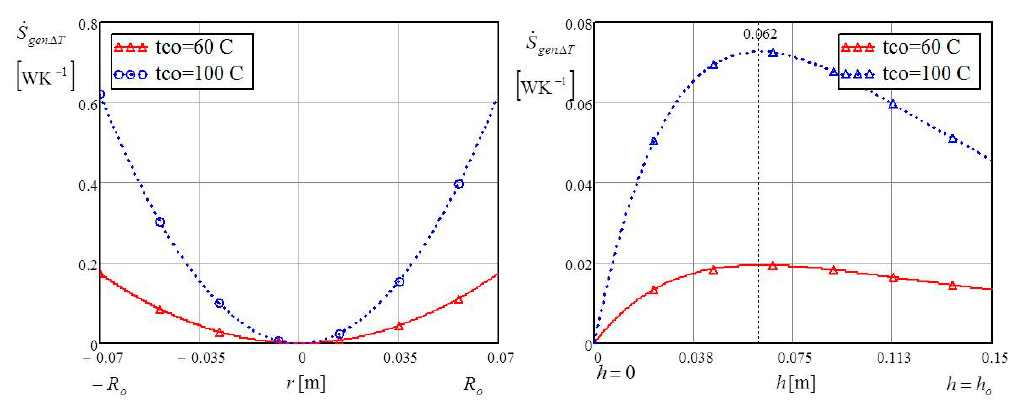
Figure 5. The thermal entropy of bottom and vertical annular cylindrical channel.